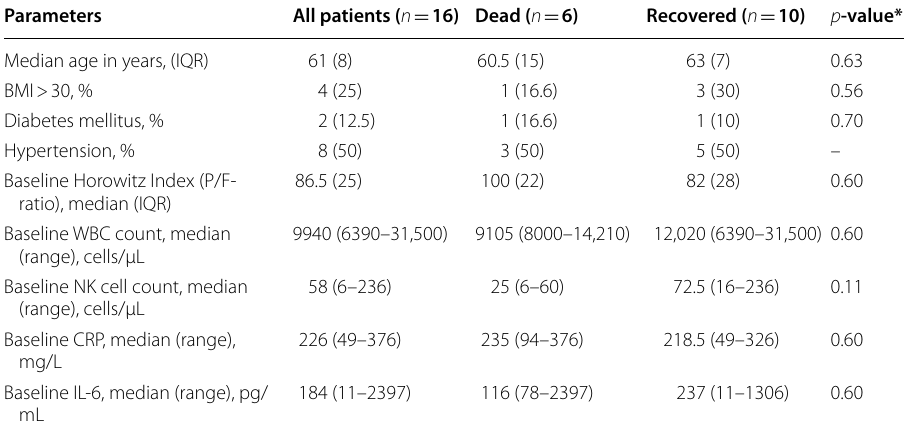
Table 1 Baseline clinical characteristics and laboratory